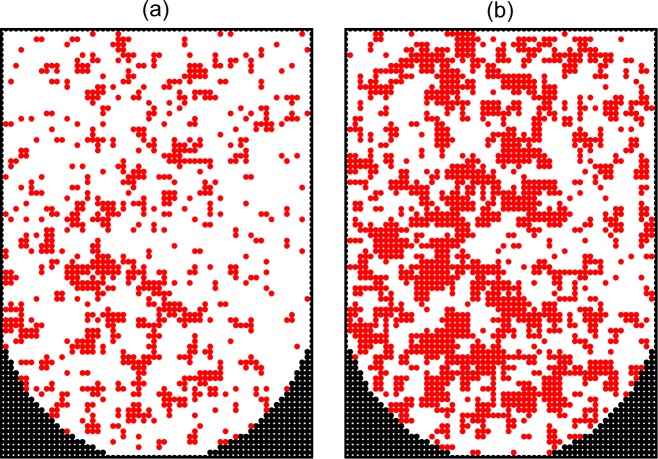
Monte Carlo simulation of cell proliferation and spheroid formation in the microwells.Cross sections of a microwell along the main axis at ϑ = 0.2 (a) and 0.4 (b) with slow cell diffusion (pdiv = 10−2) and no cell-surface adhesion (ϵcs = 0).